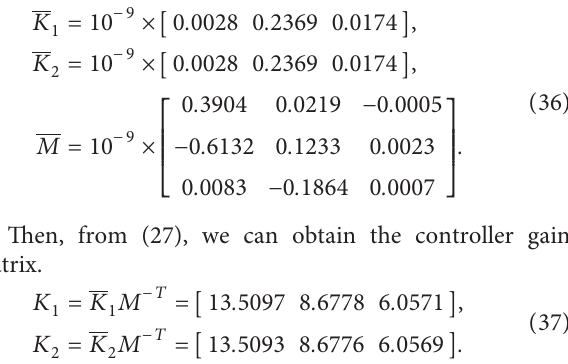
Figure 3: Responses of x